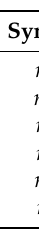
Table 4. Estimated parameter values used to fabricate the PEC